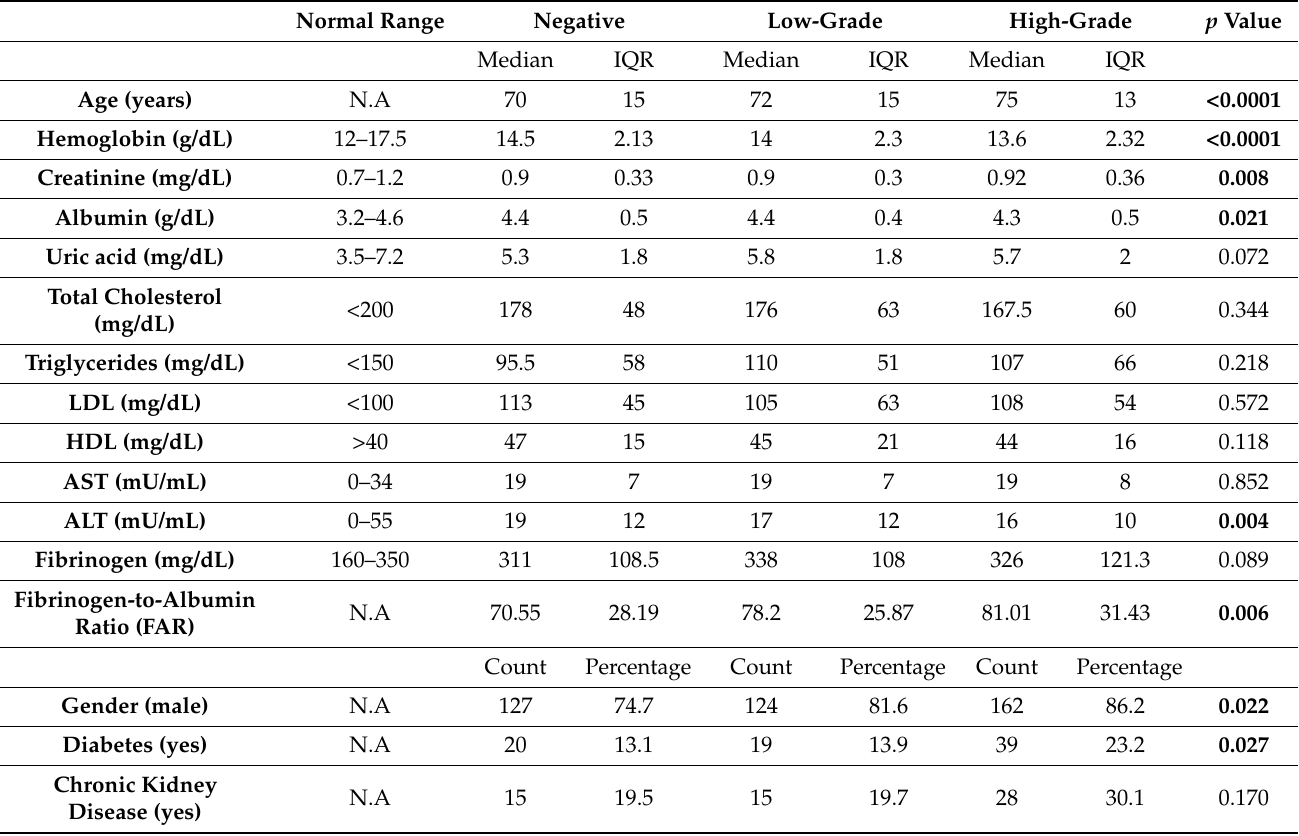
Table 2. Preoperative data according to histopathological analysis (IQR: interquartile range).